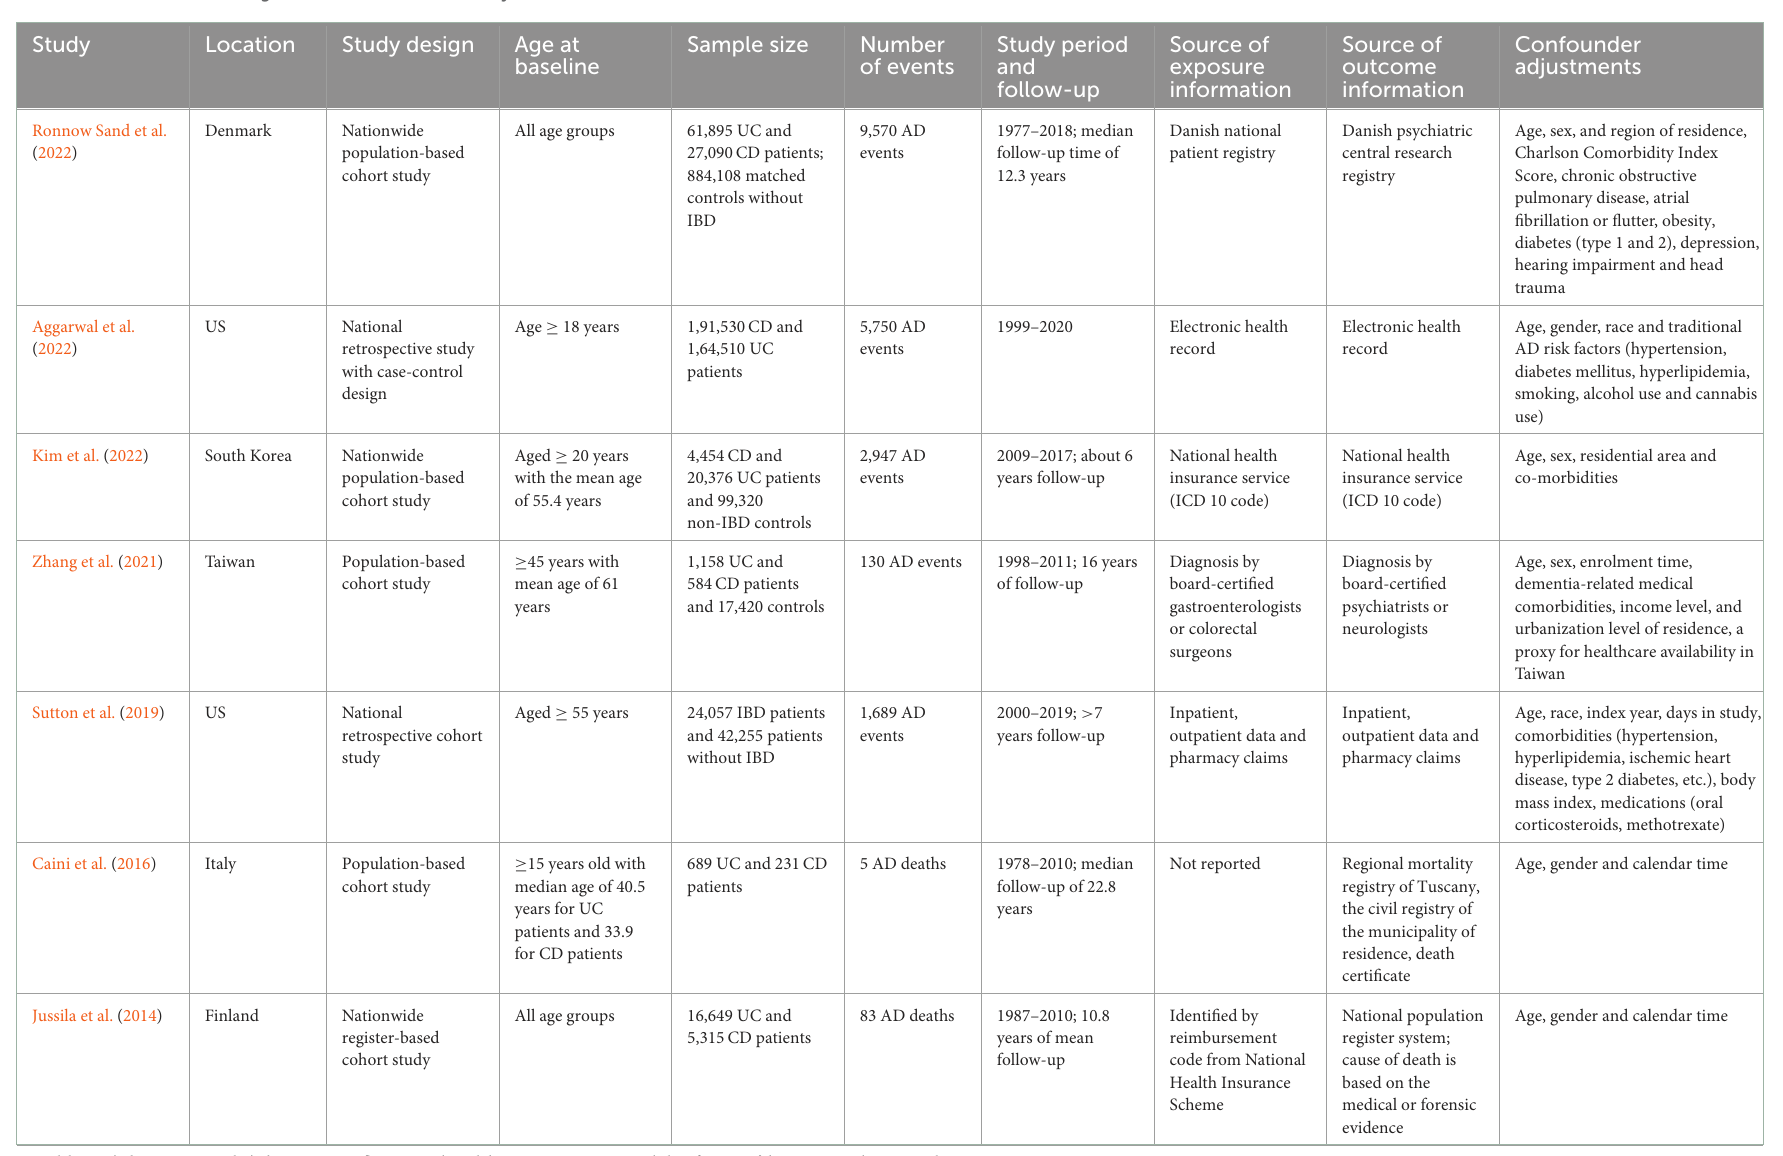
TABLE 1 Characteristics of eligible studies in the